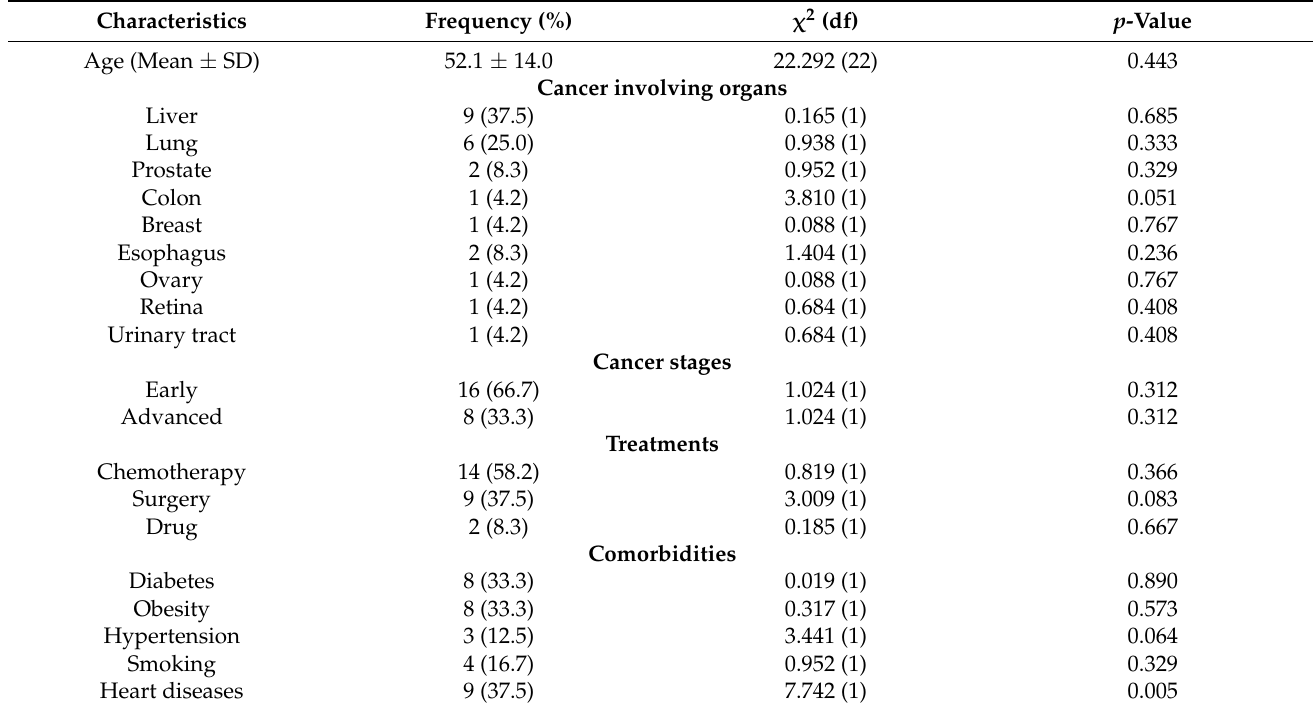
Table 4. Association of the presence of anticardiolipin antibodies and risk factors in patients with cancer (n =